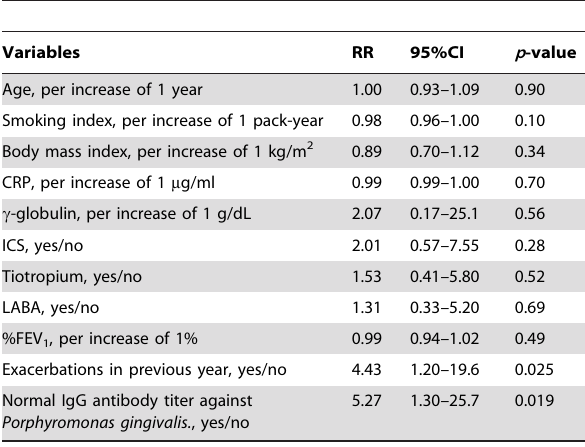
Table 5. Multivariable logistic regression analysis to identify risk factors for frequent